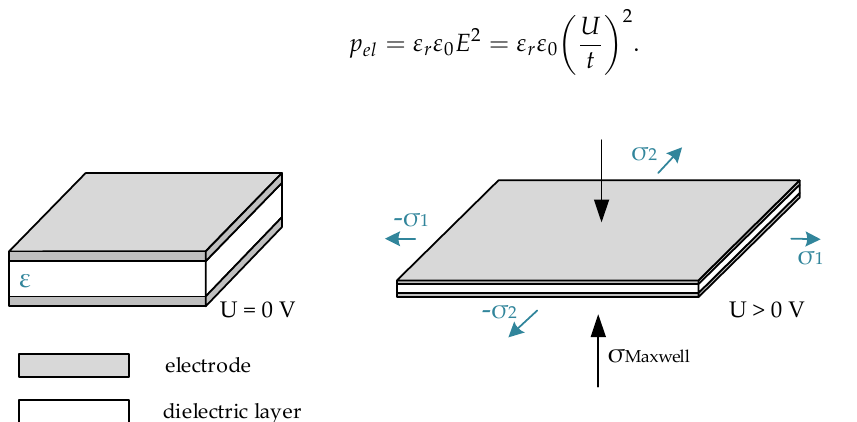
Figure 1. Schematic representation of the deforming mechanism of a dielectric elastomer actuator caused by Maxwell pressure.